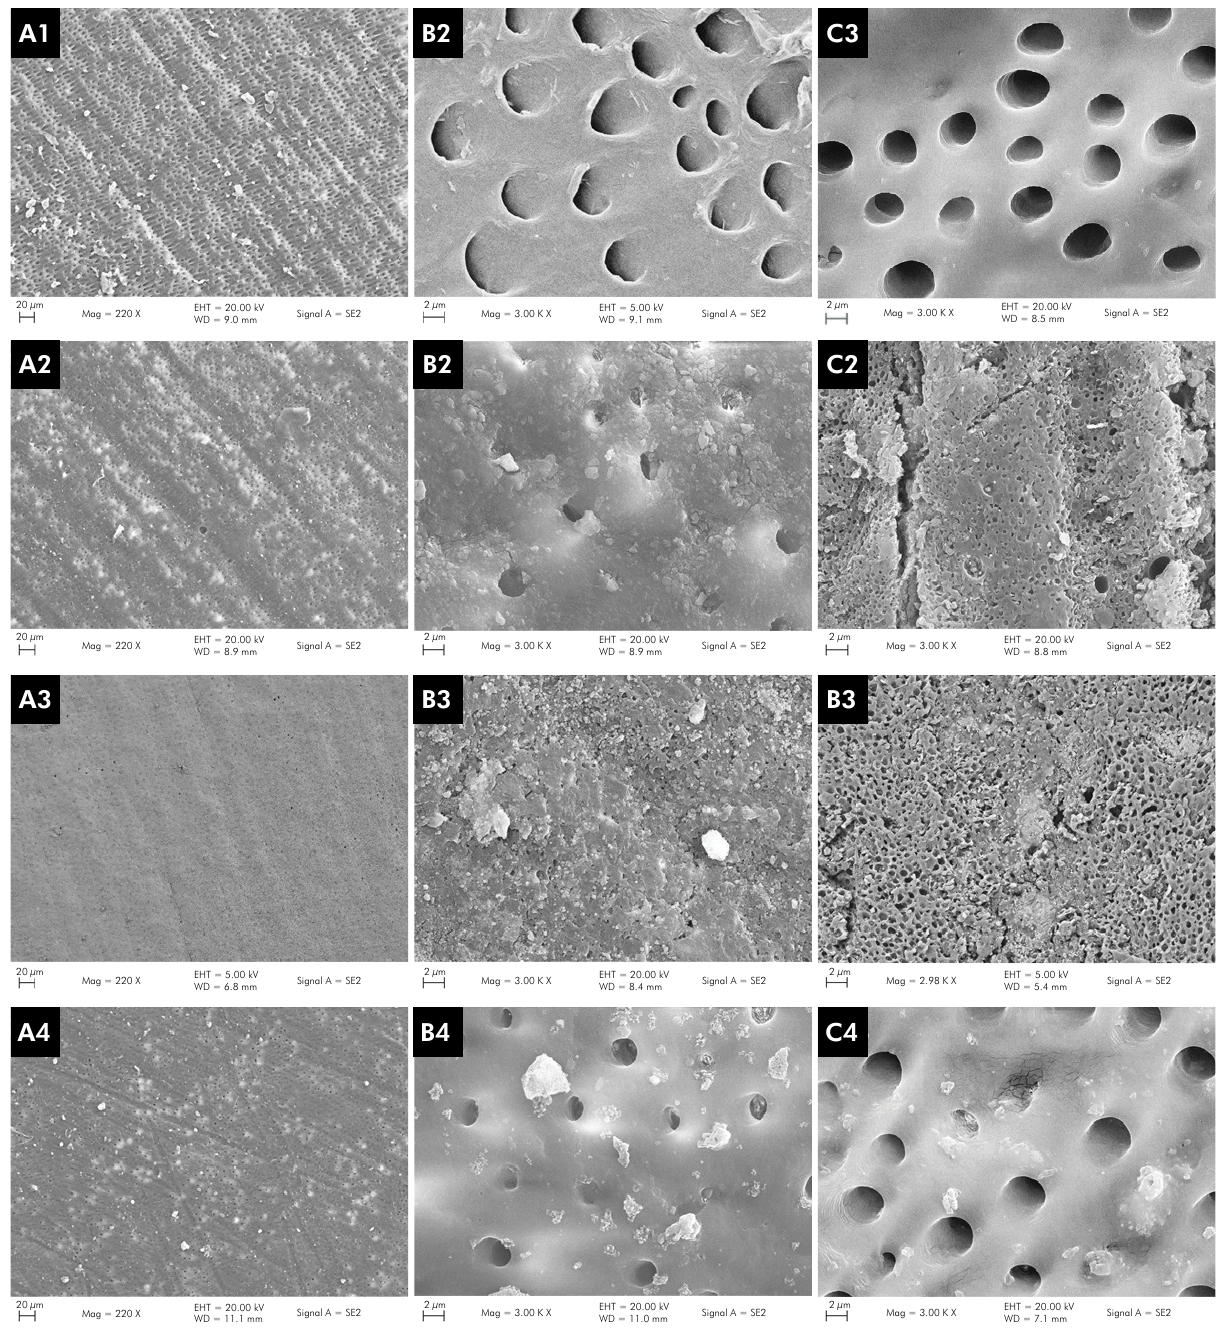
Figure 4. Representative SEM micrograph for dentine surface after treatment with different groups for 30min (A, x220; B x3000; Cx3000 Original magnification). (A1-B1) No treatment group; (A2-B2) eggshell powder treated group (A3-B3) EB@TiO group; (A4-B4) Sensodyne treated group. (Agitated for 3hours). (C2) eggshell powder groups (C3) EB@TiO Sensodyne groups. (post-exposure to 2wt. % citric acid solution for